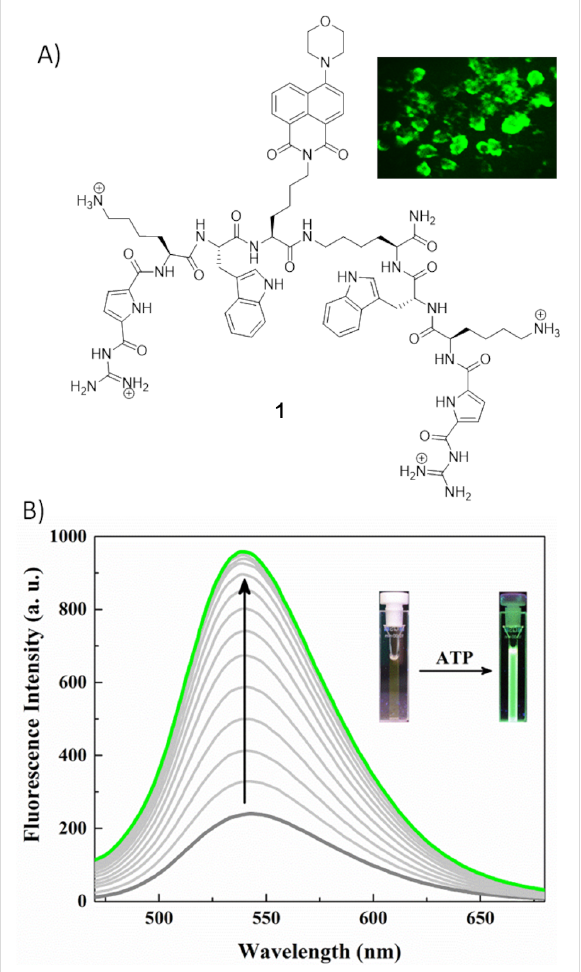
Figure 2: A) Molecular structure of peptidic probe 1 , Inset: HeLa cells incubated with peptide 1 (50 μ M), showing an ATP responsive green fluorescence; B) fluorescence emission spectra of probe 1 (20.0 µM) ( λ ex = 410 nm) with increasing concentration (0–10.0 µM) of ATP in 10 mM HEPES buffer, pH 7.4. Reproduced from [39] with permission from The Royal Society of